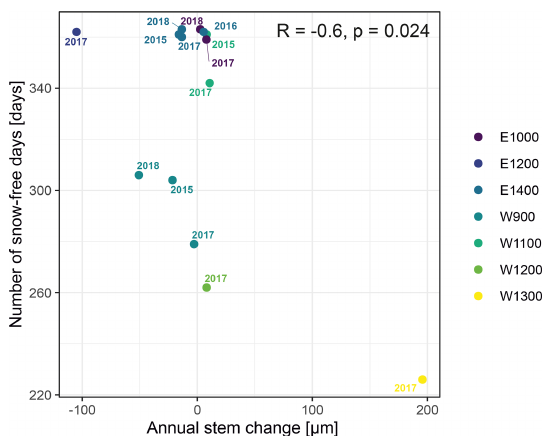
Figure A5. Number of snow-free days and annual stem diameter change in years in which no irreversible growth occurred (total annual growth = 0). Colors indicate the monitored specimens at the individual sites (E denotes east; W denotes west; numbers indicate elevation,